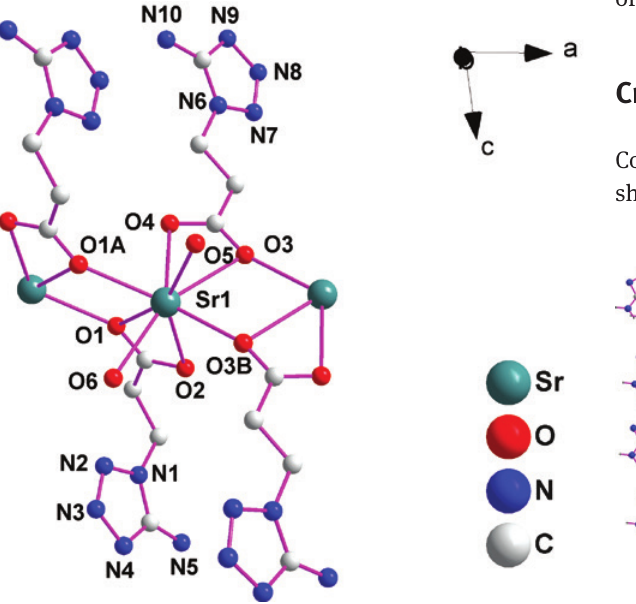
Figure 1: The coordination environment of Sr(II) in 1 . Hydrogen atoms are omitted for clarity.